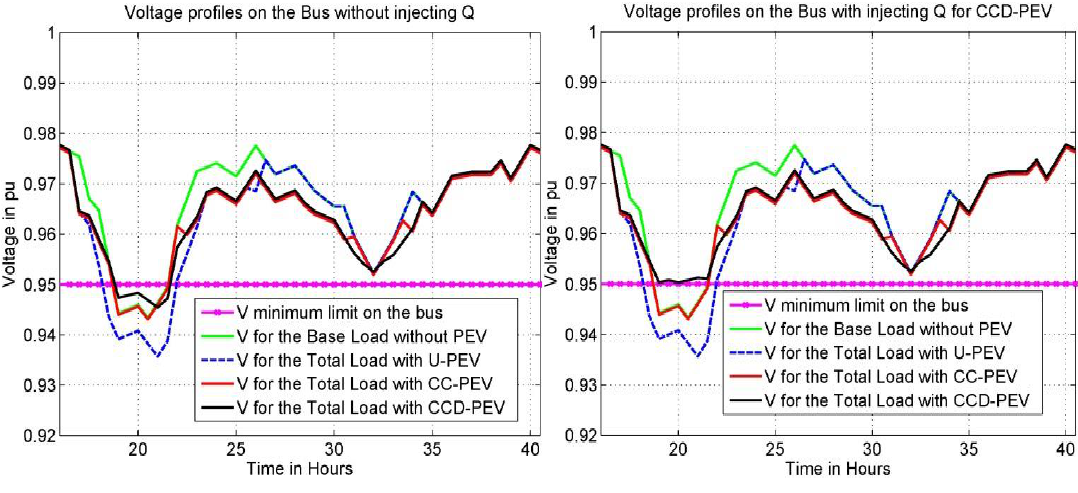
Figure 9. Voltage profiles on the bus ( a ) without and ( b ) with (injecting reactive power.